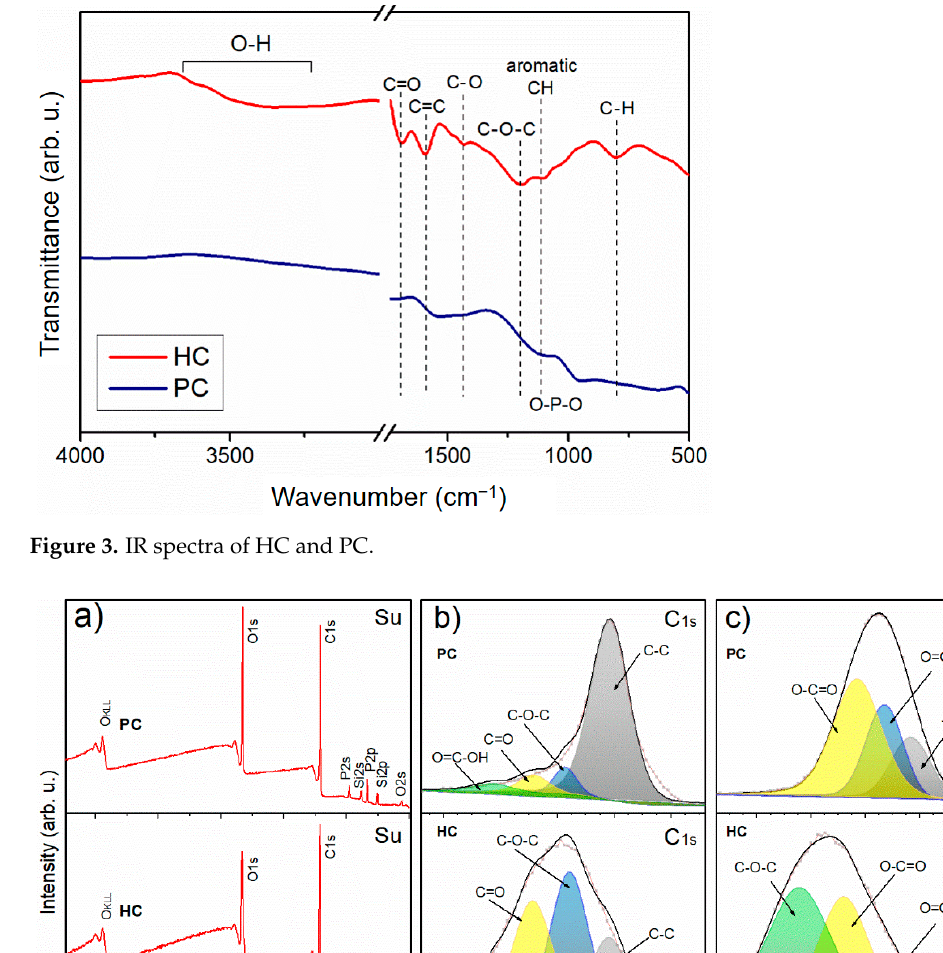
Figure 3. IR spectra of HC and PC.